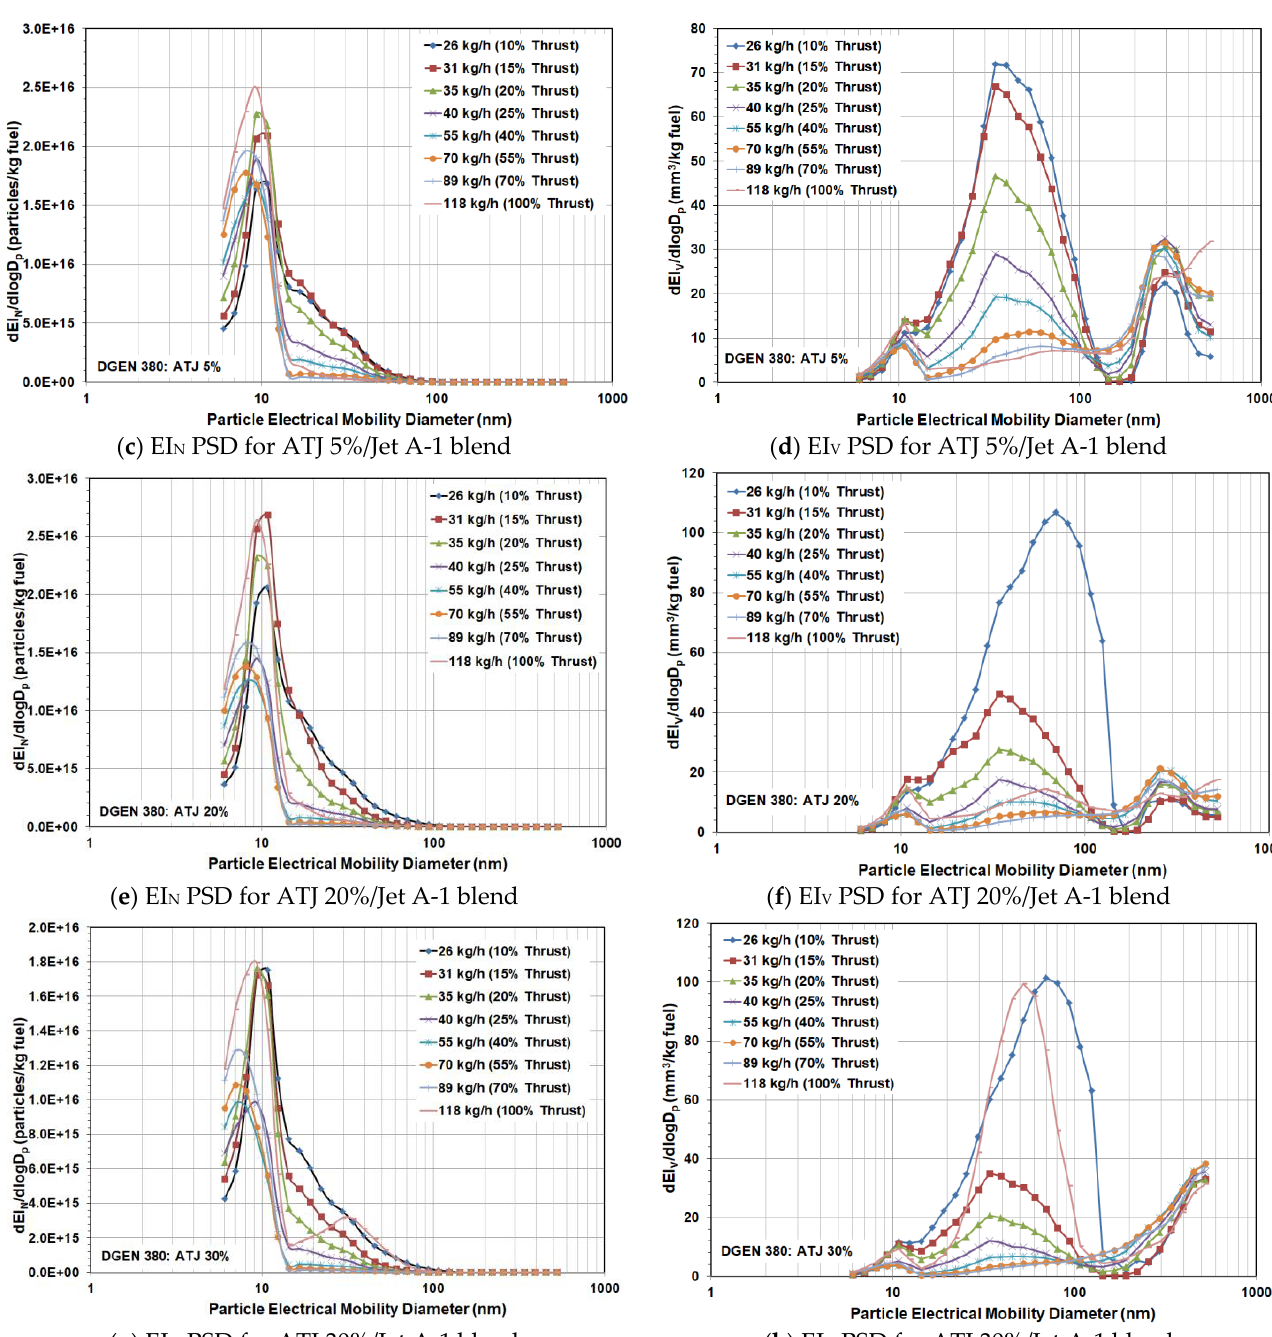
Figure 5. Differential particle number emission index (EI N ) and differential particle volume emission index (EI V ) PSDs for DGEN 380 burning Jet A-1 ( a , b ), ATJ5%/Jet A-1 blend ( c , d ), ATJ20%/Jet A-1 blend ( e , f ) and ATJ30%/Jet A-1 blend ( g , h ). Engine operating point is expressed as both fuel flow and percent rated thrust.